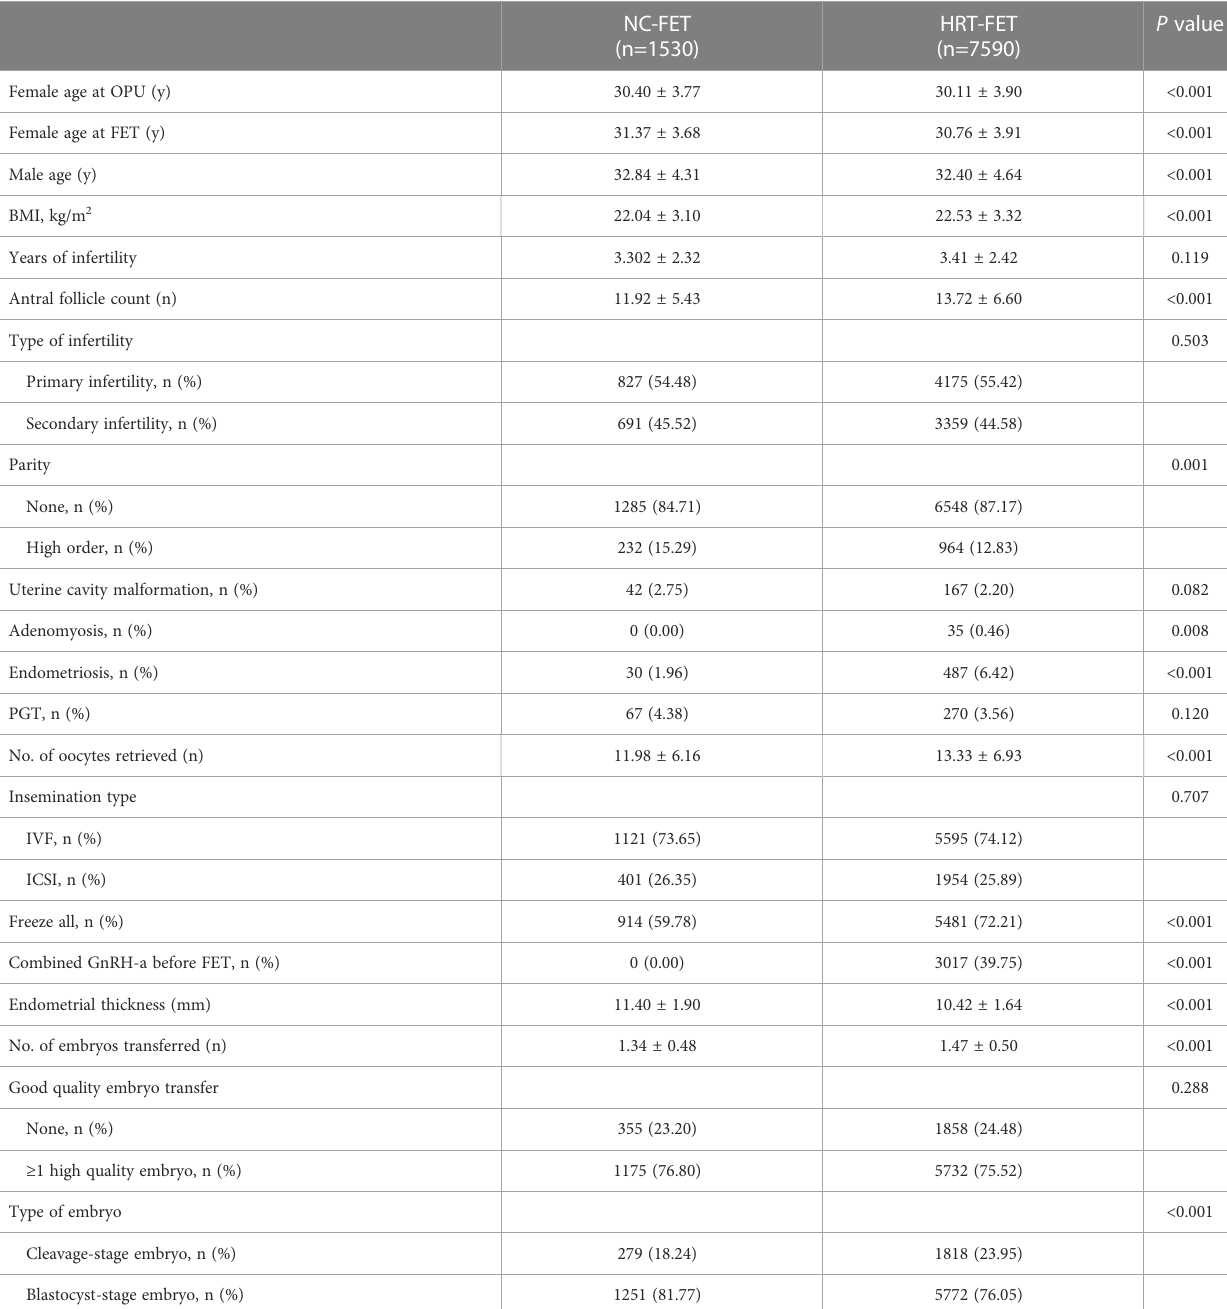
TABLE 1 Baseline characteristics of patients according to endometrium preparation